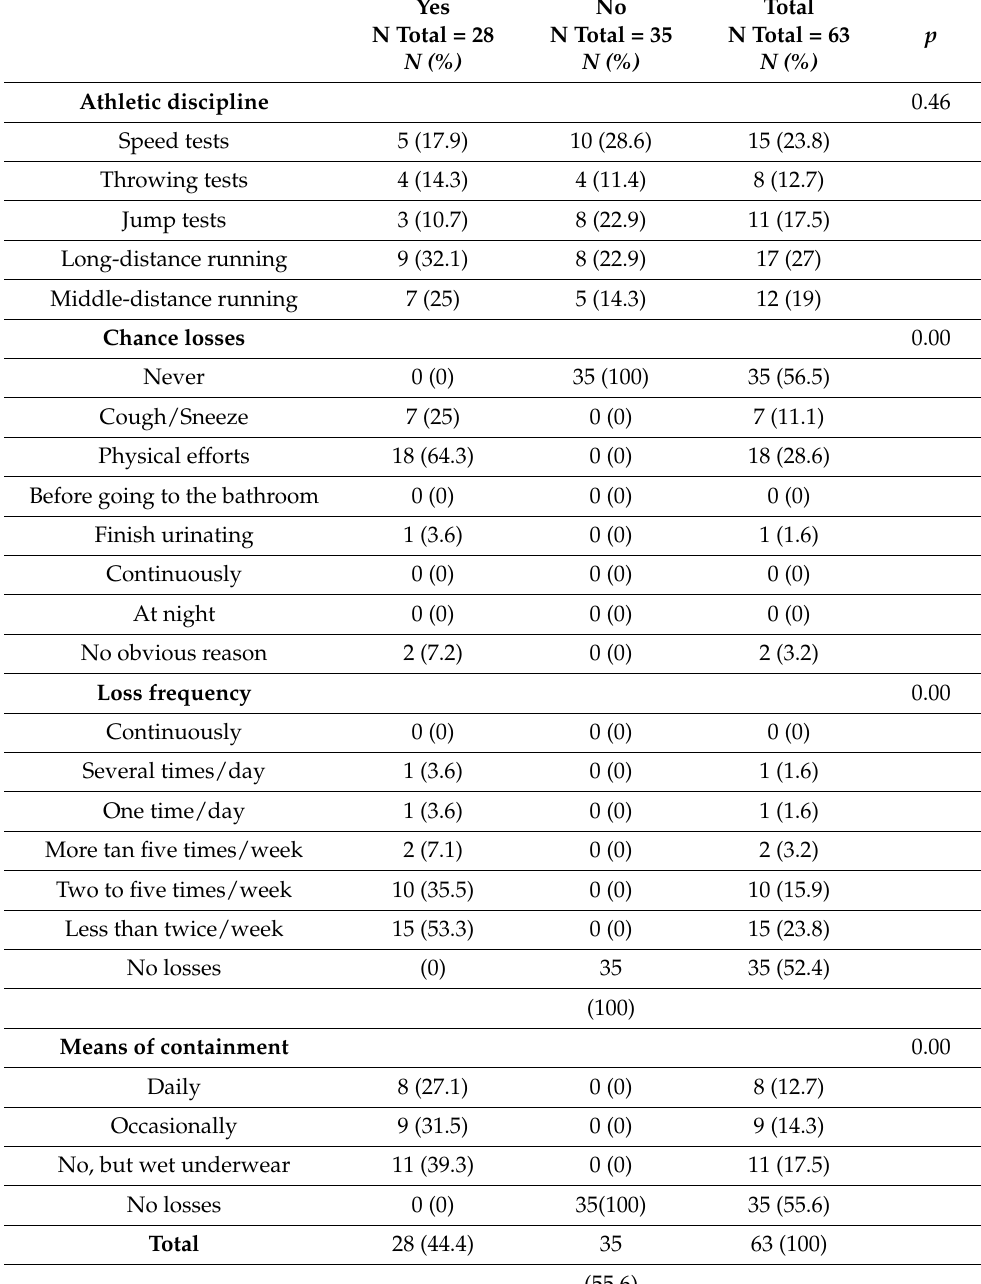
Table 1. Relationship of